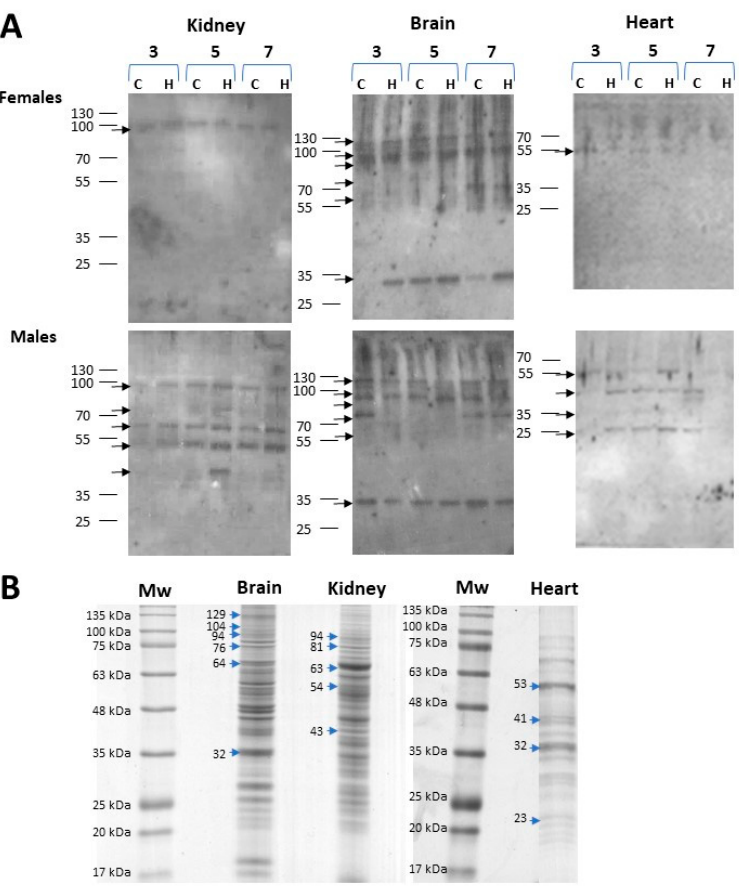
Figure 3. HNE-modified proteins in organs from female and male Hfe − / − mice. Homogenates from each organ were separately resolved on 12% polyacrylamide gels. HNE (4-hydroxynonenal) modified pro- teins were detected by Western blot using HNE specific antibodies. ( A ) Western blot analysis of HNE adducts in kidney, brain, and heart proteins from female and male control (C) and Hfe − / − (H) mice at 3, 5 and 7 months of age. Images are representative of n = 3 per group. ( B ) Coomassie brilliant blue-stained gels where HNE-immunoreactive bands protein bands were excised. Arrows indicate the protein bands that were excised from the gel and the molecular weight are expressed in KDa on the left side of the arrow.